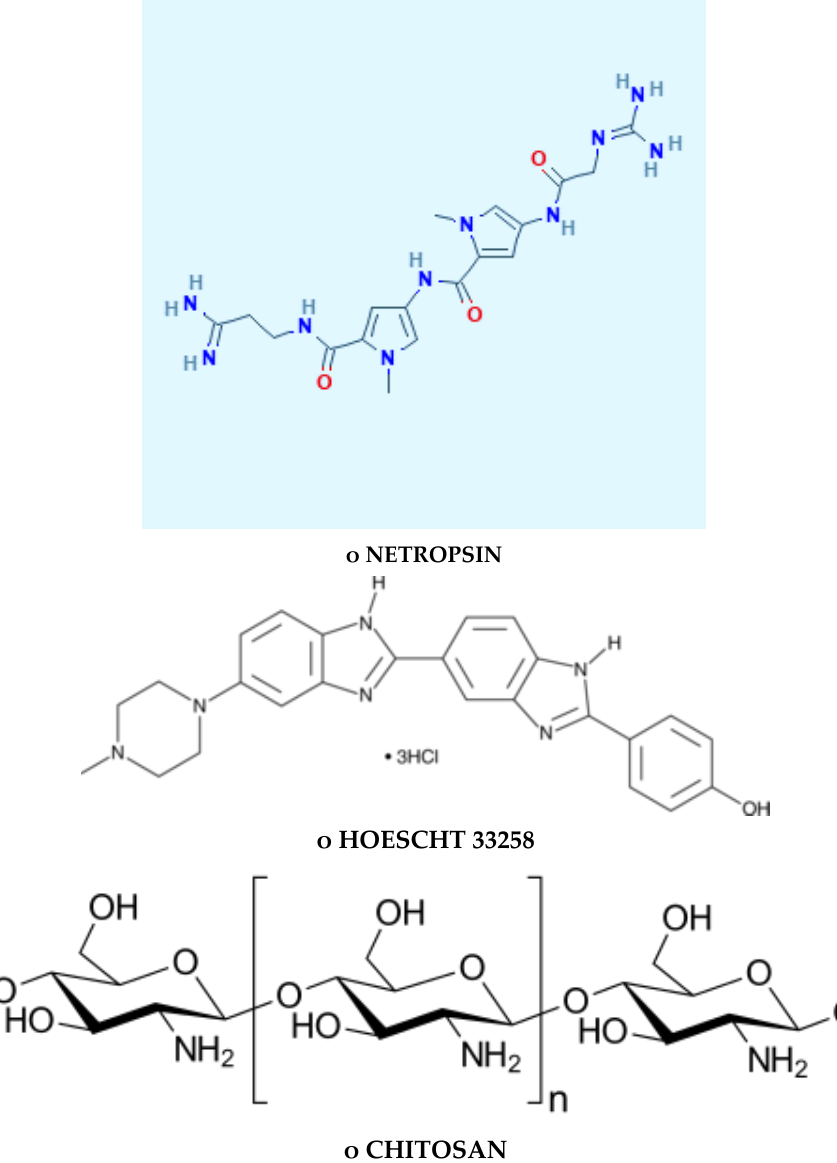
Figure 1. Structural formulas of compounds with a potential to complex with the DNA minor groove. Structure formula origin from PubChem-NIH.